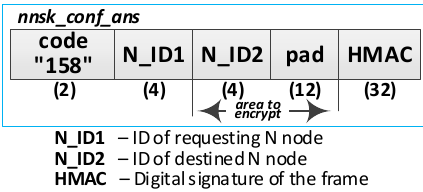
Figure 28. The response to the frame of session key confirmation request.